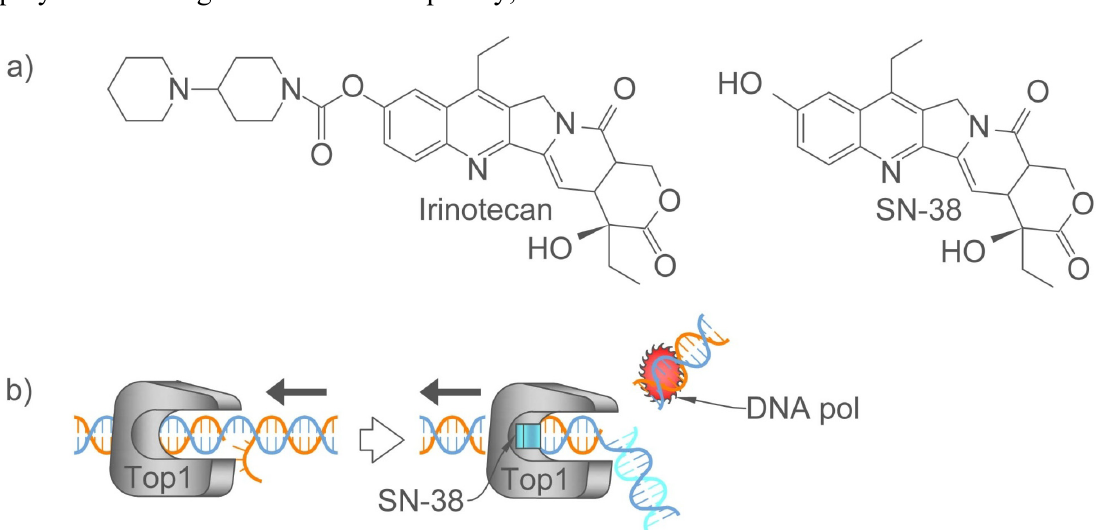
Figure 2. ( a ) Chemical structure of irinotecan and its metabolite, and ( b ) the mechanism of action of irinotecan, DNA topoisomerase I (Top1) cleaves and unwinds the DNA, as part of DNA replication and transcription. SN-38 forms a complex with DNA and Top1, inhibiting the religation of the DNA strand and blocking the movement of the DNA polymerase along the DNA. Consequently, a DNA double strand break